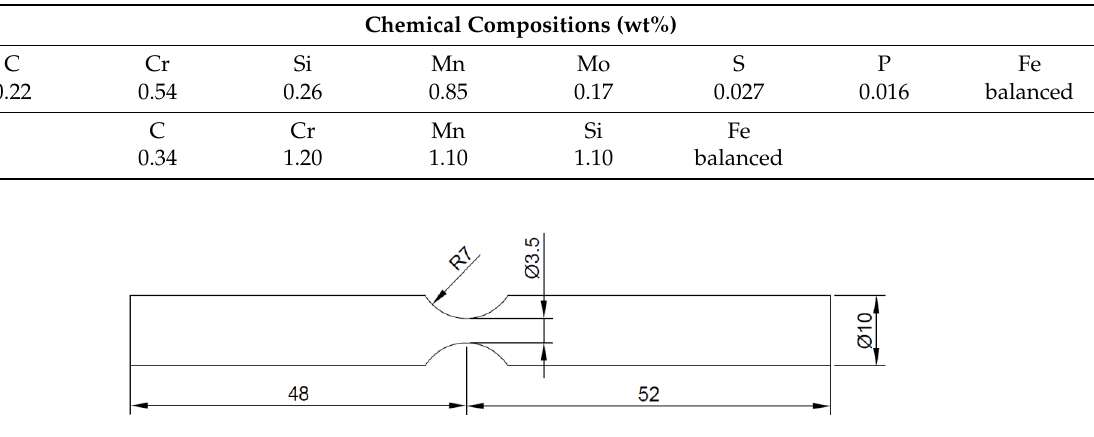
Figure 1. Geometry of specimens for rotating bending fatigue tests (in mm).